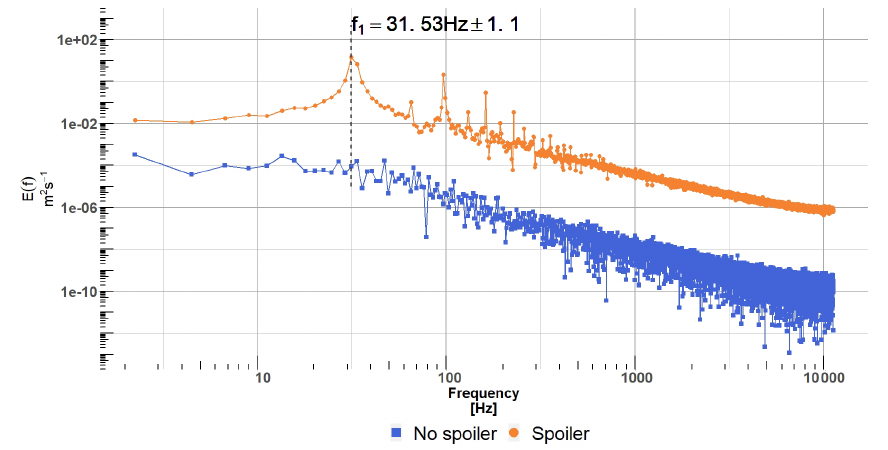
Figure 13. Horizontal velocity PSD, in the wake, at x c = 3 . 0. The blue square (blue (cid:4) ) shows the no spoiler case while the orange dot (orange • ) shows the spoiler case.